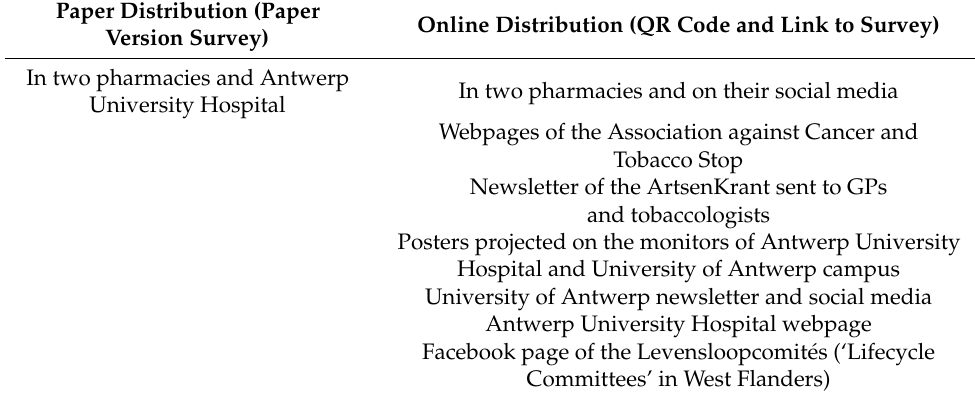
Table 2. Detailed information on the distribution techniques used for the online and paper version of the